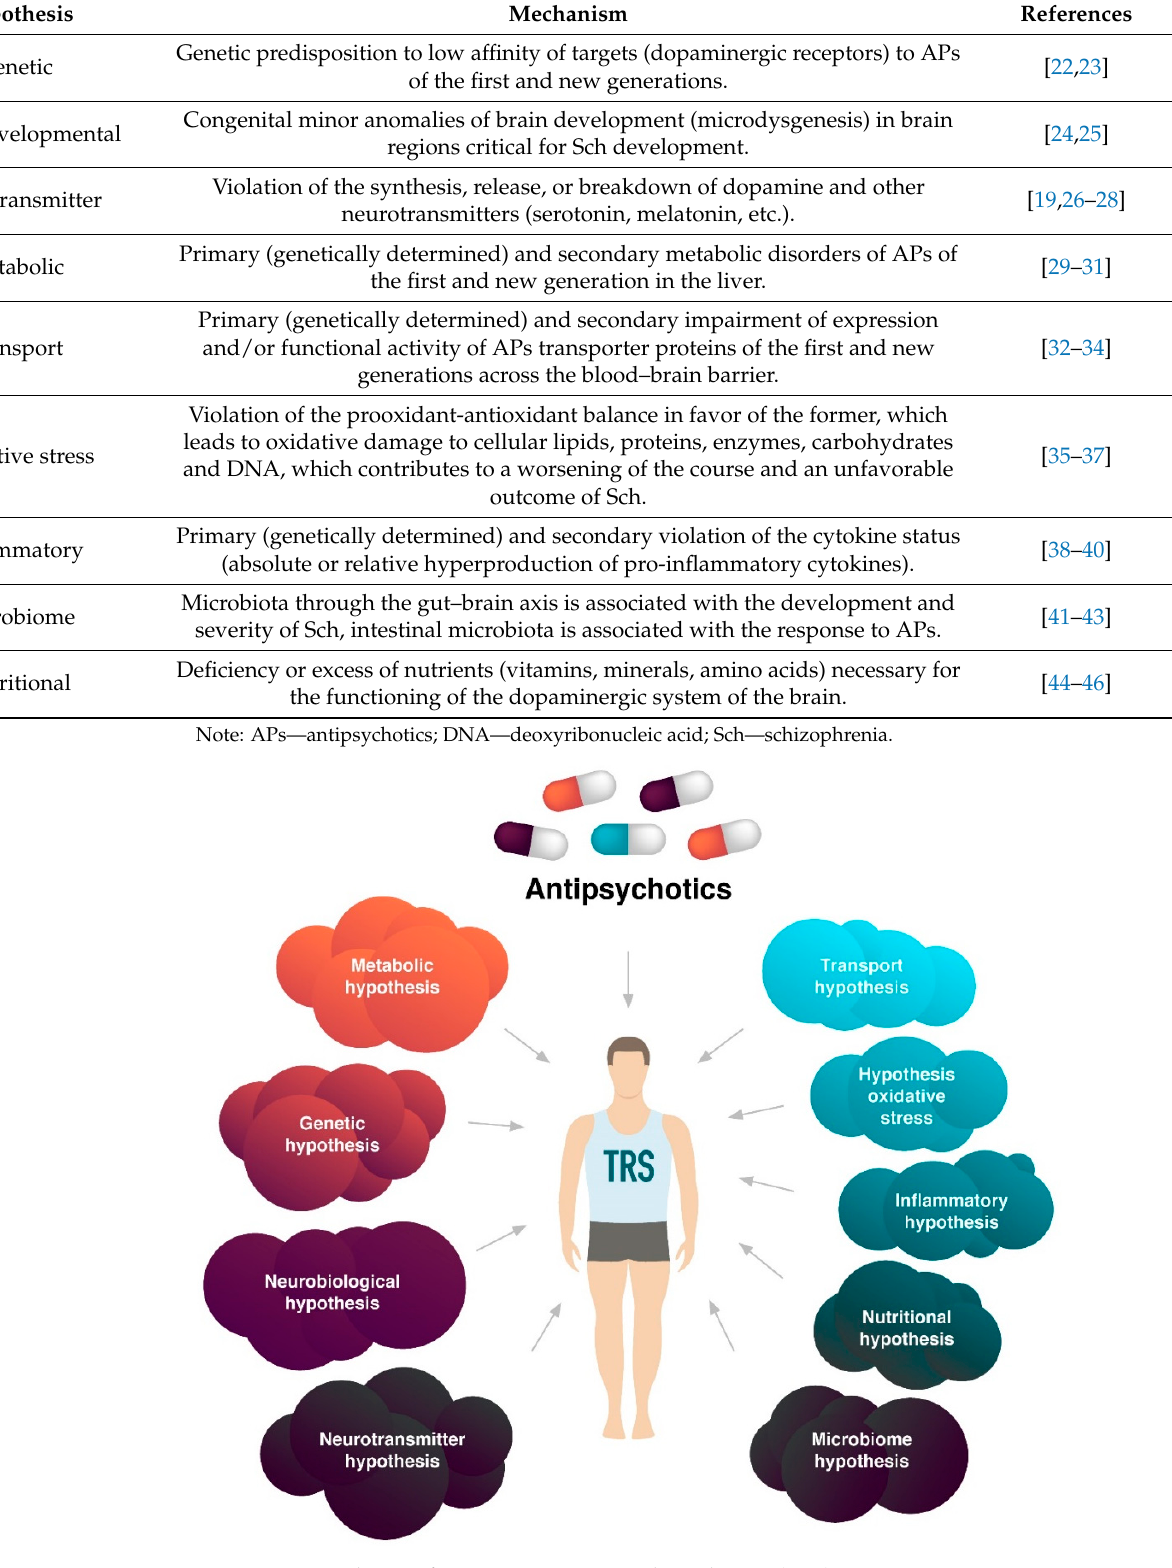
Figure 2. Hypotheses of treatment-resistant schizophrenia (TRS).